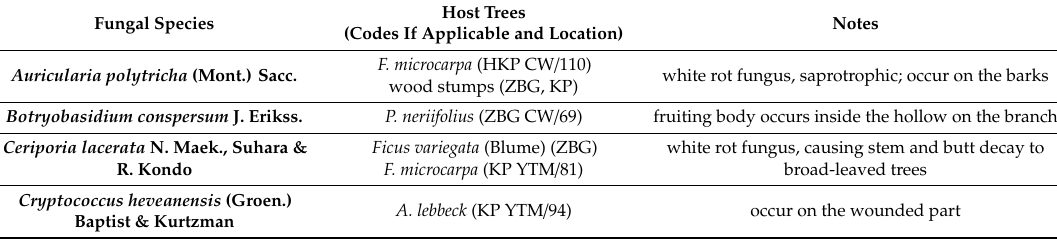
Table 2. A list of wood-decay fungi detected during the study, together with their host trees, locations and significances